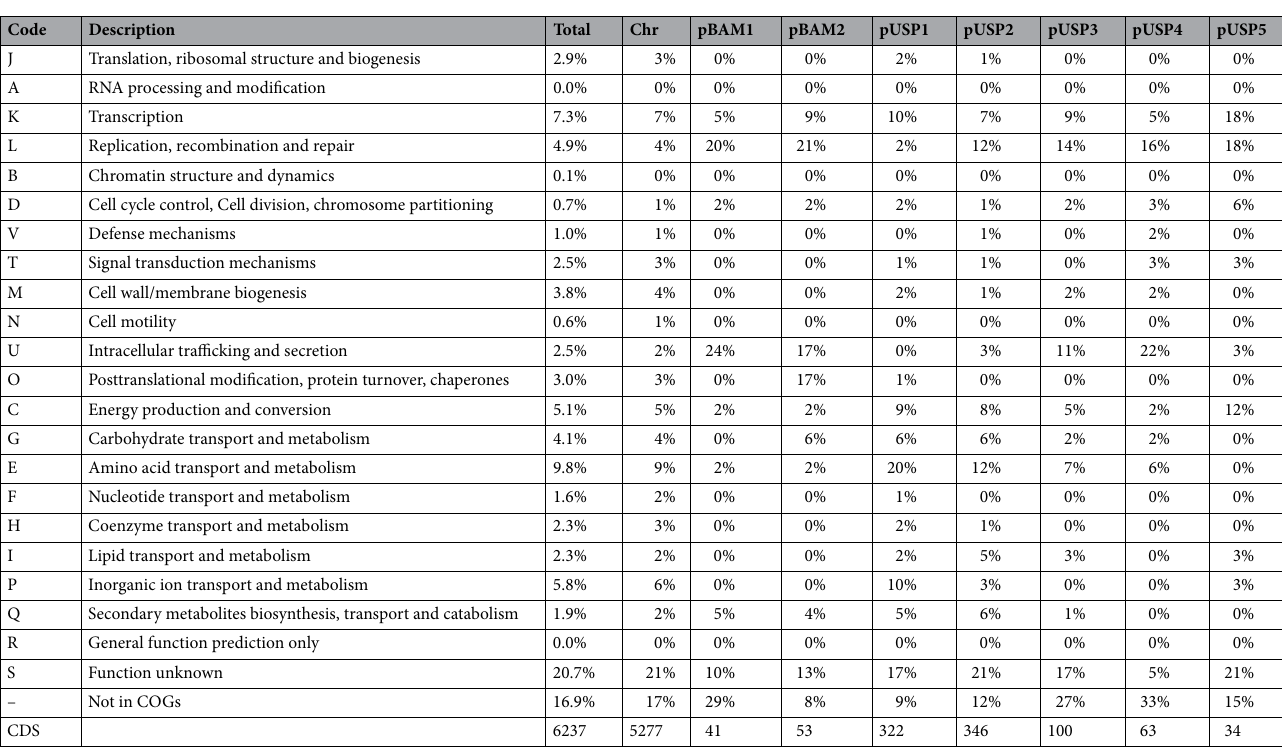
Table 3. Percentage of genes associated with general COG functional categories in genome and